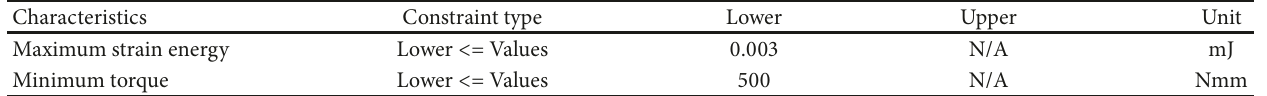
Table 7: Bounds of the quality responses.